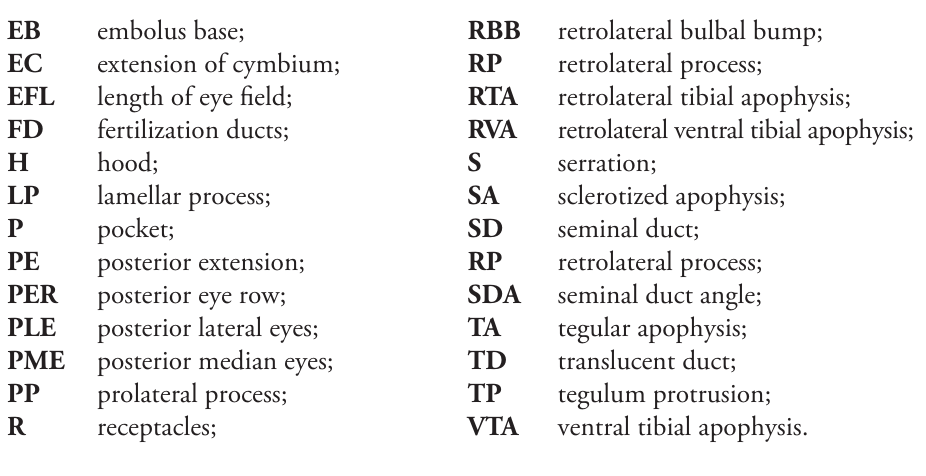
Table 1. Voucher specimen information, Species